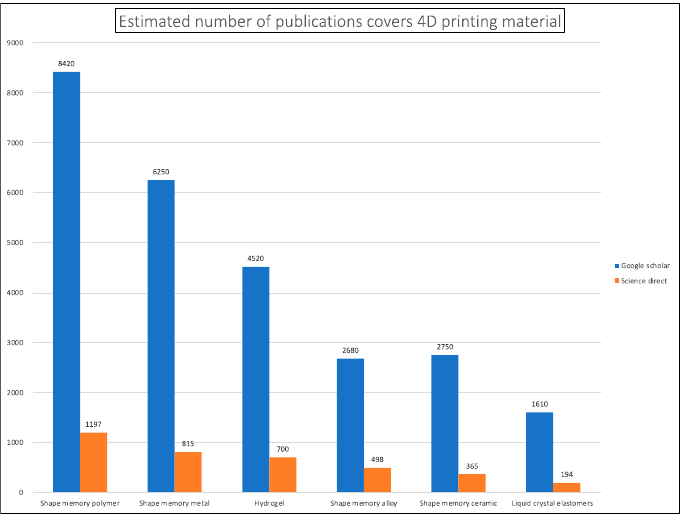
Figure 4. Number of publications about 4D printing for each material between 2013 and 2022 in the Google Scholar and ScienceDirect databases (as of 30 November 2022).